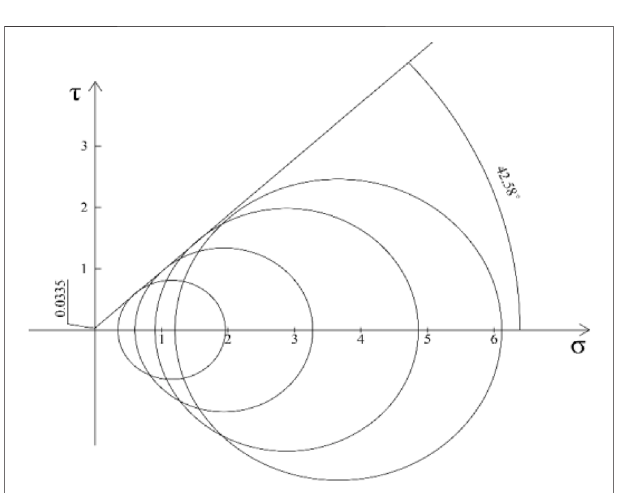
FIGURE 8 | Mohr circle of whole stone slag diagram.